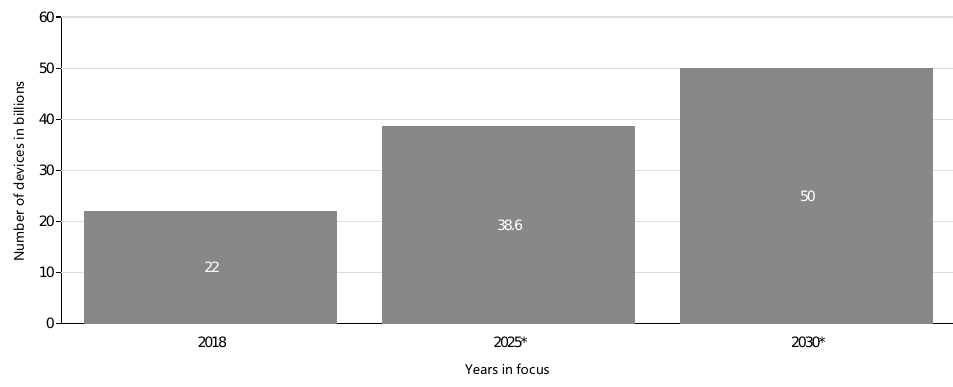
Figure 5. Forecast of the number of IoT-connected devices by 2030 [2].